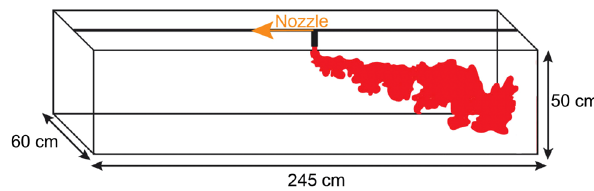
Fig. 5 Schematic illustration of the wind-blown plume in the experimental tank. A nozzle is located at the top of the tank and moves at a constant speed from the right to the left side of the tank during an experiment. Six experiments were carried out, with nozzle speeds of 0.104, 0.092,